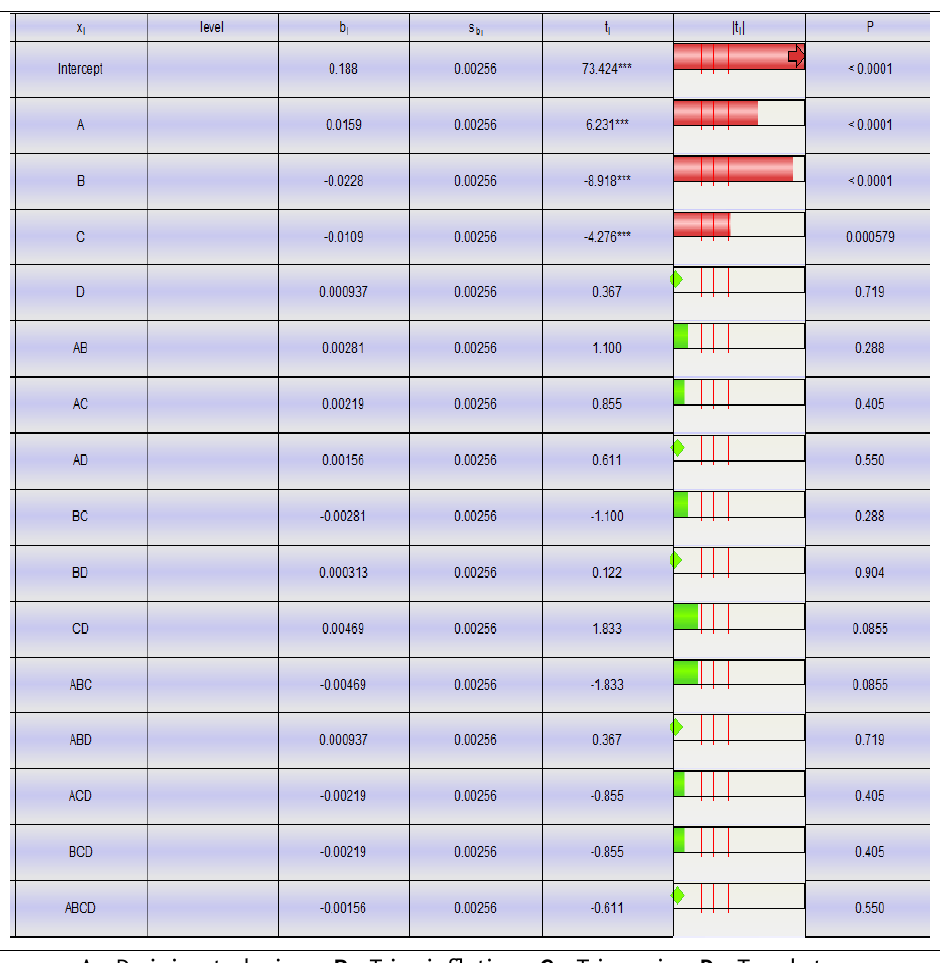
Table 5 –Evaluation of full factorial design